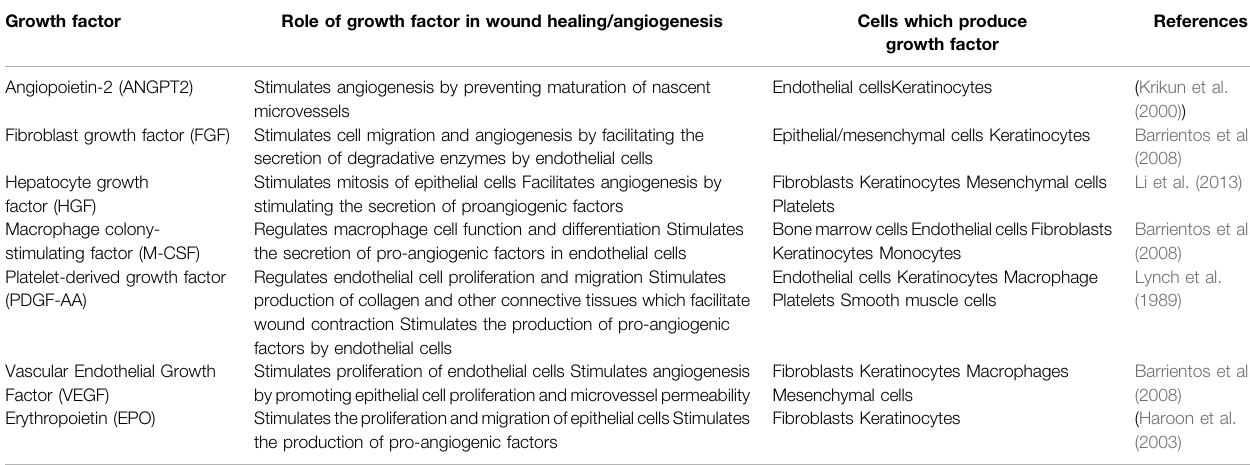
TABLE 1 | Human growth factors secreted by keratinocytes and their role in wound healing/angiogenesis. Growth